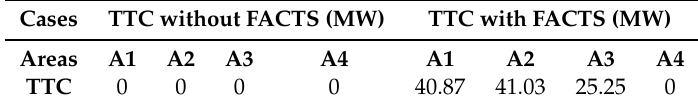
Table 2. TTC values of overall system for IEEE 24 bus system.